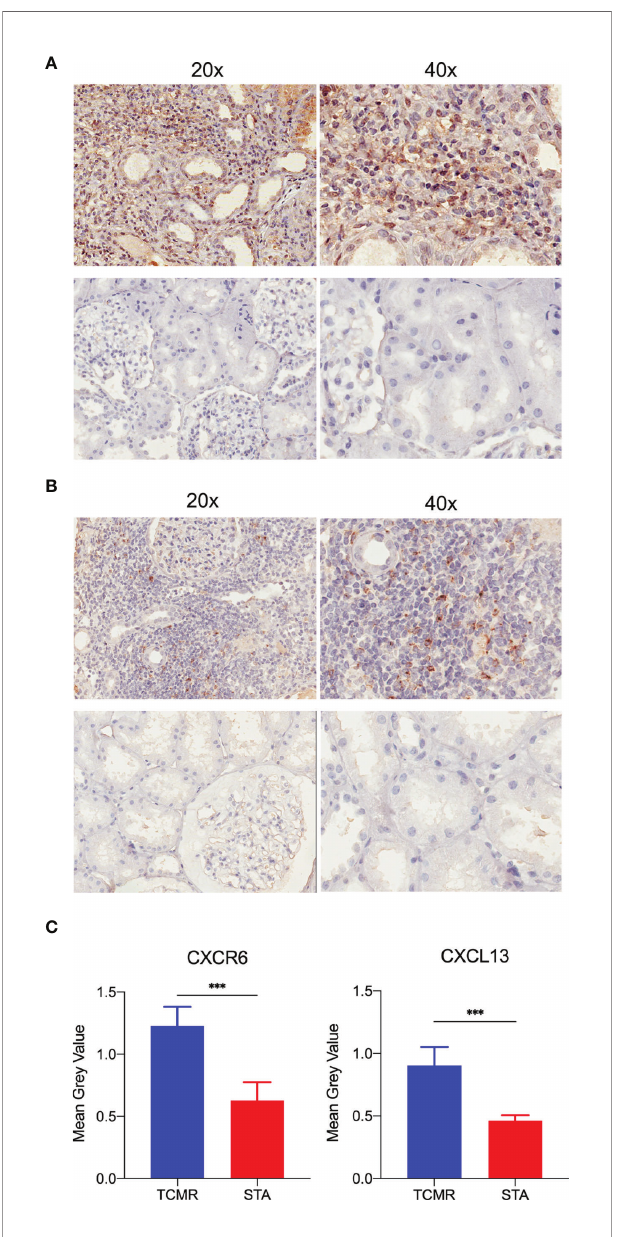
FIGURE 7 | The immunohistochemistry staining and image analysis of CXCR6 and CXCL13 in human renal biopsy samples. (A) Immunohistochemistry staining of CXCR6 in TCMR and STA samples. (B) Immunohistochemistry staining of CXCL13 in TCMR and STA samples. (C) Semi-quantitative analysis of CXCR6 and CXCL13 in immunohistochemistry staining by mean grey value. *** p <